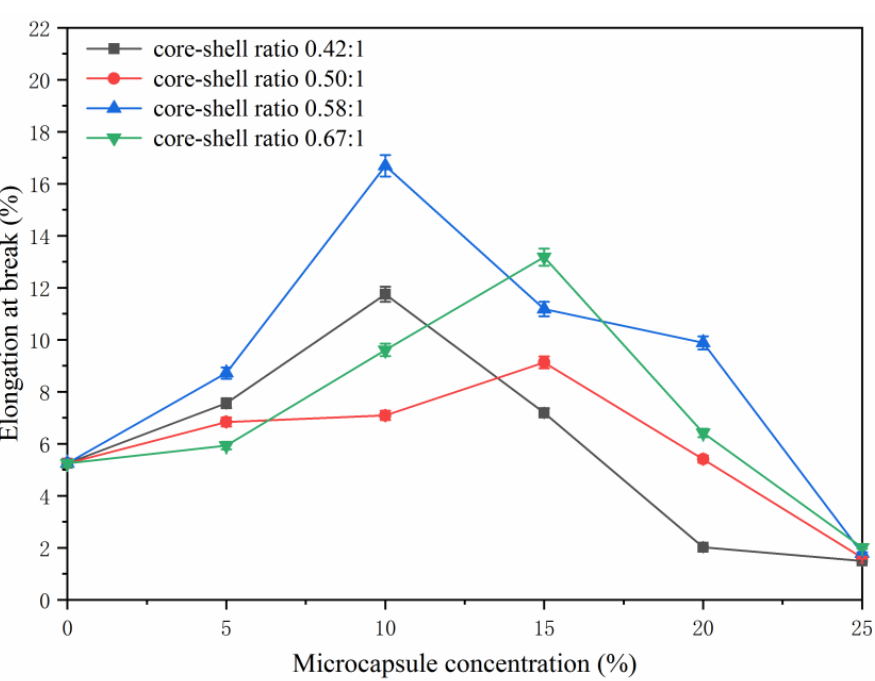
Figure 3. Effect of microcapsule concentration and core-shell ratio on elongation at break of paint